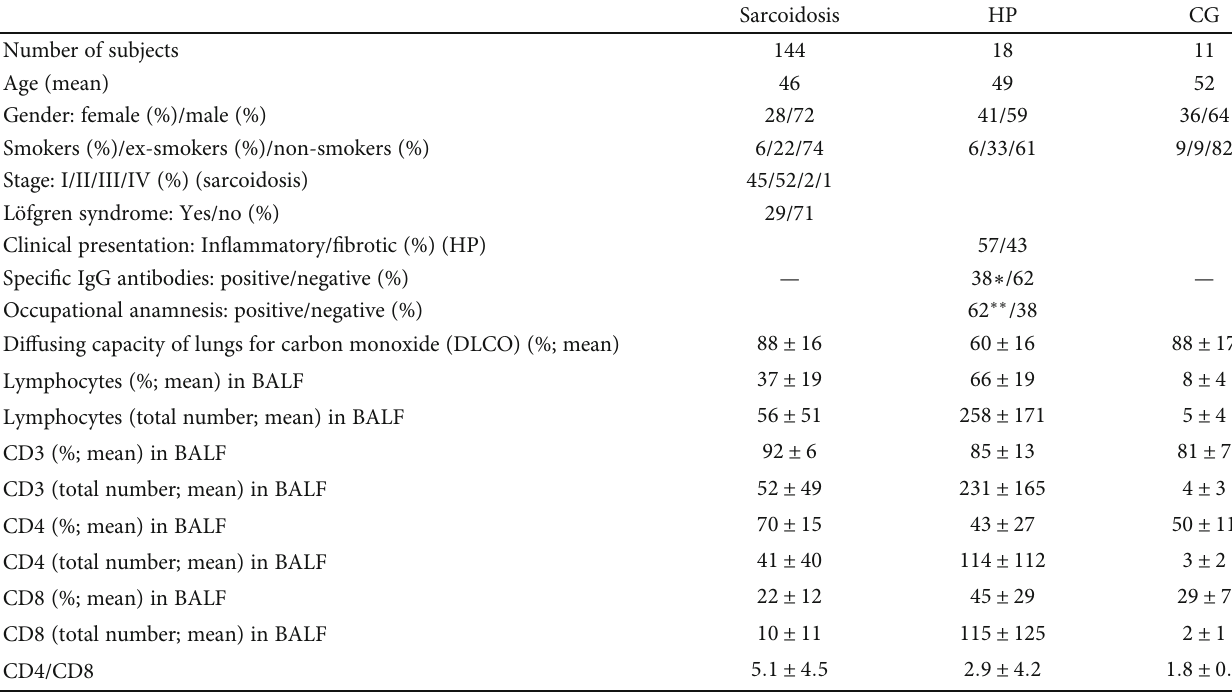
Table 2: Characteristics of the study